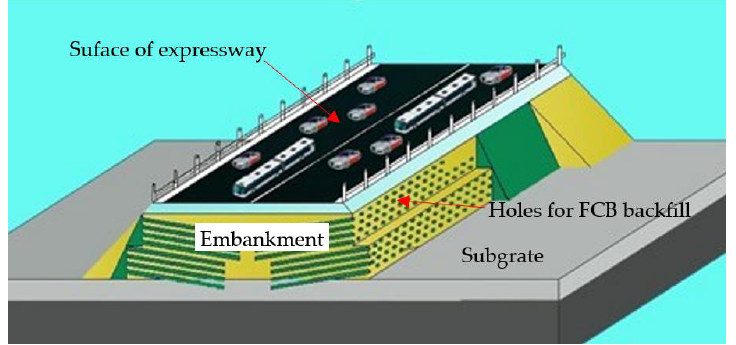
Figure 1. Embankment FCB replacement construction by citing transverse holes.